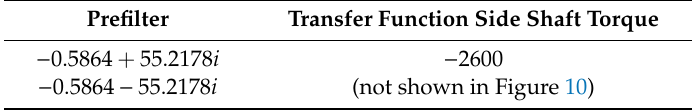
Table 3. Zeros of the Transfer function of the prefilter and the simplified real system.